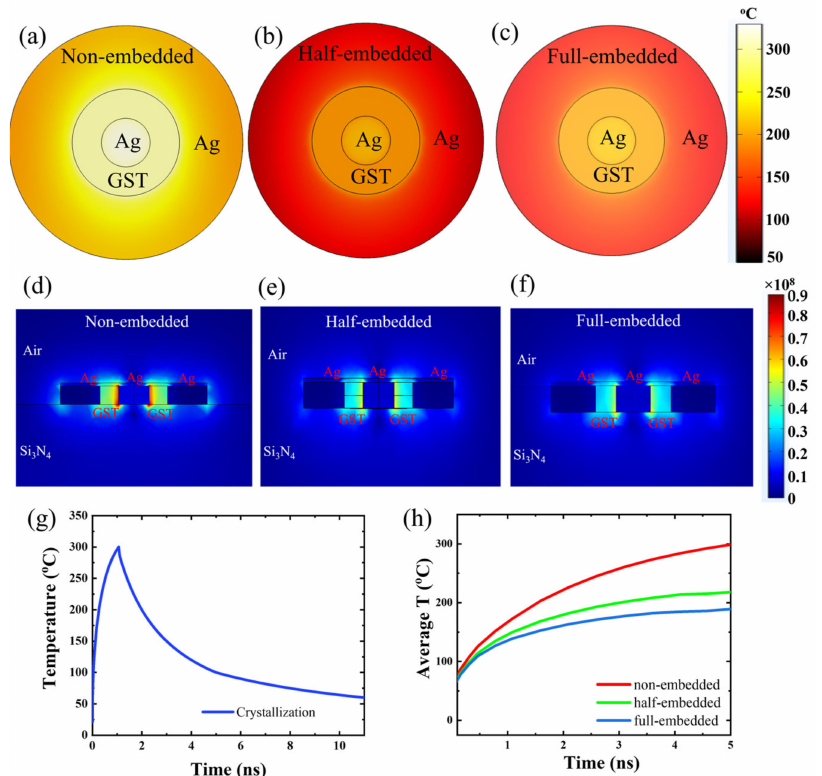
Figure 5. Surface temperature distribution of the cross-sectional integrated nanoantenna devices for ( a ) non-embedded, ( b ) half-embedded, and ( c ) full-embedded. Instantaneous electric field diagram for erasing operation of the cross-sectional integrated nanoantenna devices for ( d ) non-embedded, ( e ) half-embedded, and ( f ) full-embedded. ( g ) Thermal transient response of the PCM cell during crystallization. ( h ) The average temperature under the same pulse power at three different